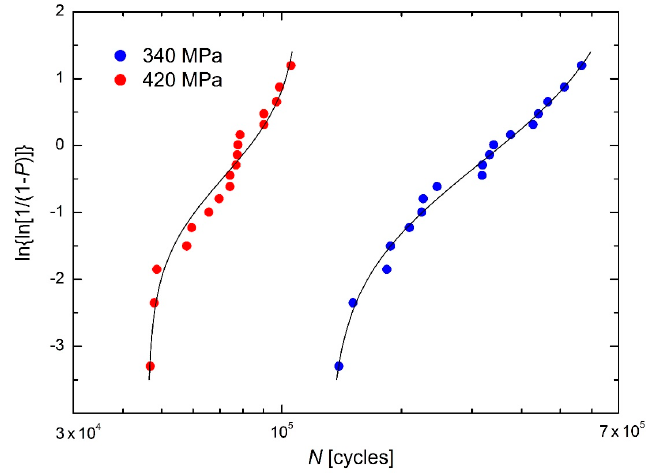
Figure 9. Weibull plots of the number of cycles to fracture for the FeE 460 steel cyclically loaded with σ max = 340 MPa and 420 MPa [13].